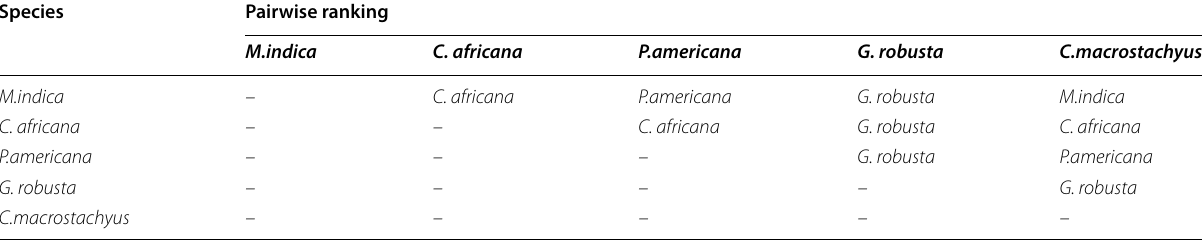
Table 6 Pairwise ranking of tree/shrub species nominated for litter study in the homegarden agroforestry systems of the study sites, southwestern and southern Ethiopia Species Pairwise ranking